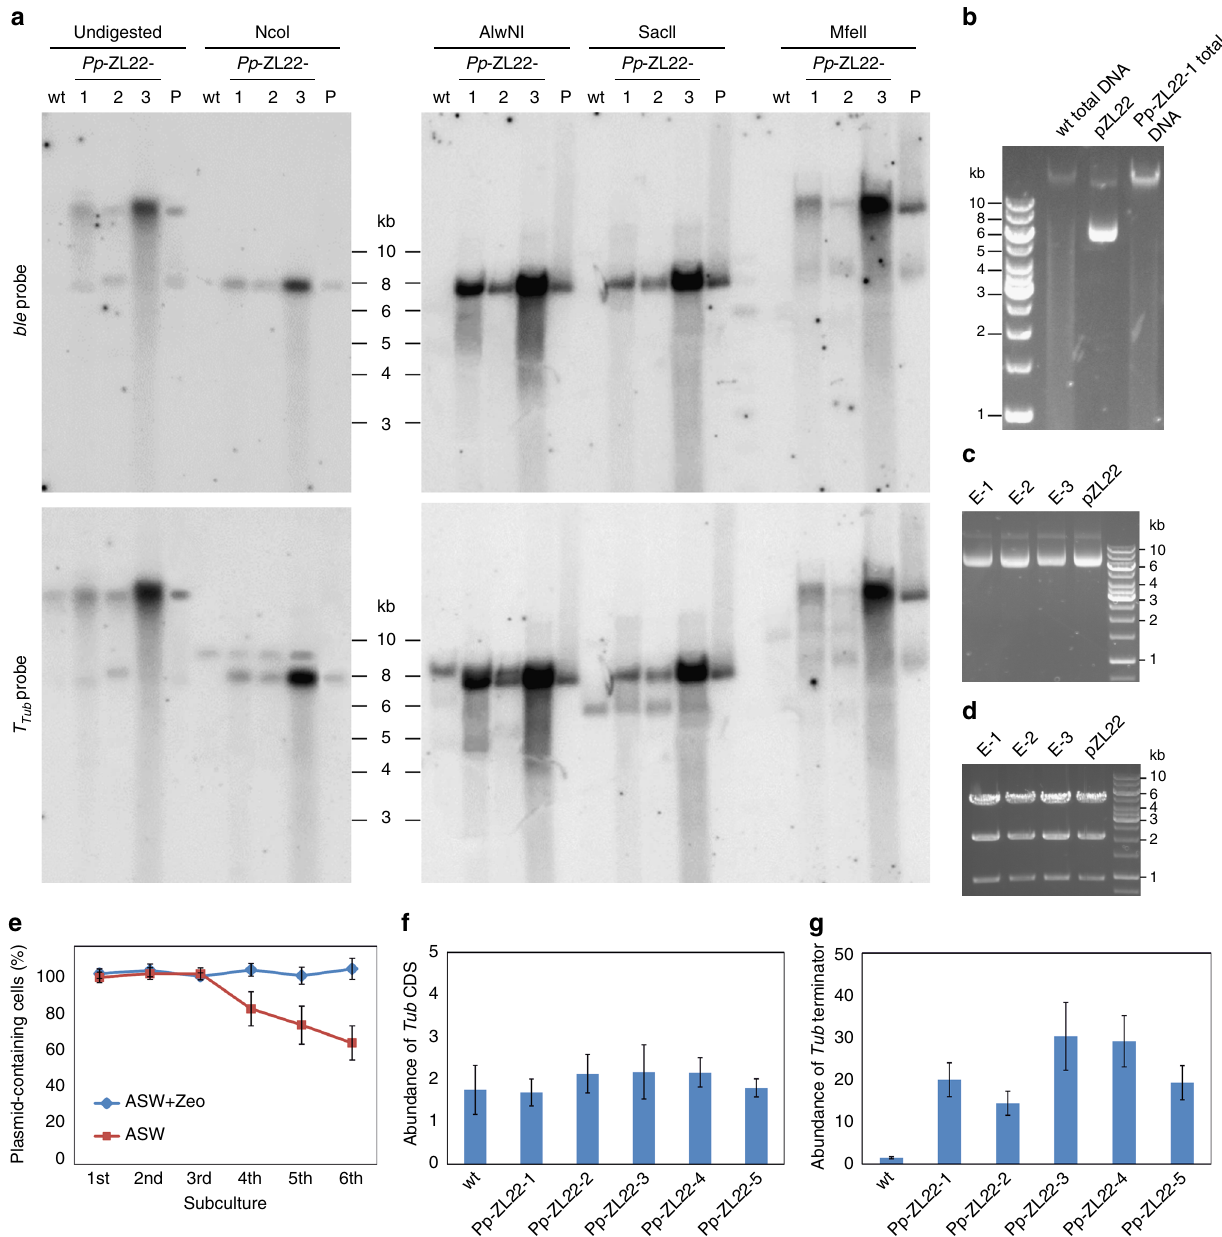
Fig. 2 Transformed plasmids replicate as stable, circular, high-copy number episomes. a Southern blot of transgenic algal clones. DNA from the wild-type (wt) and three transgenic strains obtained with vector pZL22 was left undigested or cut with restriction enzymes that have a single recognition site in the vector. pZL22 isolated from E. coli (P) served as control. NcoI: methylation-insensitive enzyme, AlwNI: sensitive to dcm methylation, SacII: sensitive to CpG methylation, MfeII: methylation-insensitive (no site in pZL22). The blots were sequentially hybridized with the two probes ( ble coding region, T Tub terminator). For Southern blots of transgenic strains generated with pZL6 and pZL19, see Supplementary Fig. 3. b Analysis of genomic DNA by gel electrophoresis. DNA from the wild-type strain, a transformed Pp -ZL22 strain, and the puri fi ed plasmid were separated in a 1% ethidium bromide- containing agarose gel. c Rescued plasmids isolated from E. coli . DNA of algae transformed with pZL22 was extracted 6 months after transformation (and continuous subculturing in selective medium) and transformed into bacteria. Plasmids were isolated from three antibiotic-resistant colonies (E-1, E-2, E-3) and analyzed by gel electrophoresis. Plasmid pZL22 was loaded as control. d Analysis of rescued plasmids by digestion with EcoRI. The rescued plasmids and the transformation vector pZL22 produce identical restriction patterns. e Plasmid loss assay with transgenic algal strains that were subcultured (by diluting the culture 1:1000) in arti fi cial sea water (ASW) without selection for six successive cycles. After each cycle, aliquots were plated on agar-solidi fi ed ASW with and without zeocin. Plasmid loss was determined as the percentage of plasmid-containing cells (i.e., colonies on medium with zeocin: colonies on medium without antibiotic). f , g Determination of the copy number of the episomes relative to the algal nuclear genome. The abundance of the tubulin coding region (CDS; f ) and the tubulin terminator ( g ) were determined by qPCR using DNA from the wild-type and fi ve independent Pp -ZL22 transformants. The EF1 α gene served as reference. Presence of the tubulin terminator in both the transgene and the tubulin gene in the genome allows copy number determination of the episome. Error bars: SD of the mean from three biological replicates. For qPCR ef fi ciency of the primer pairs, see Supplementary Fig.